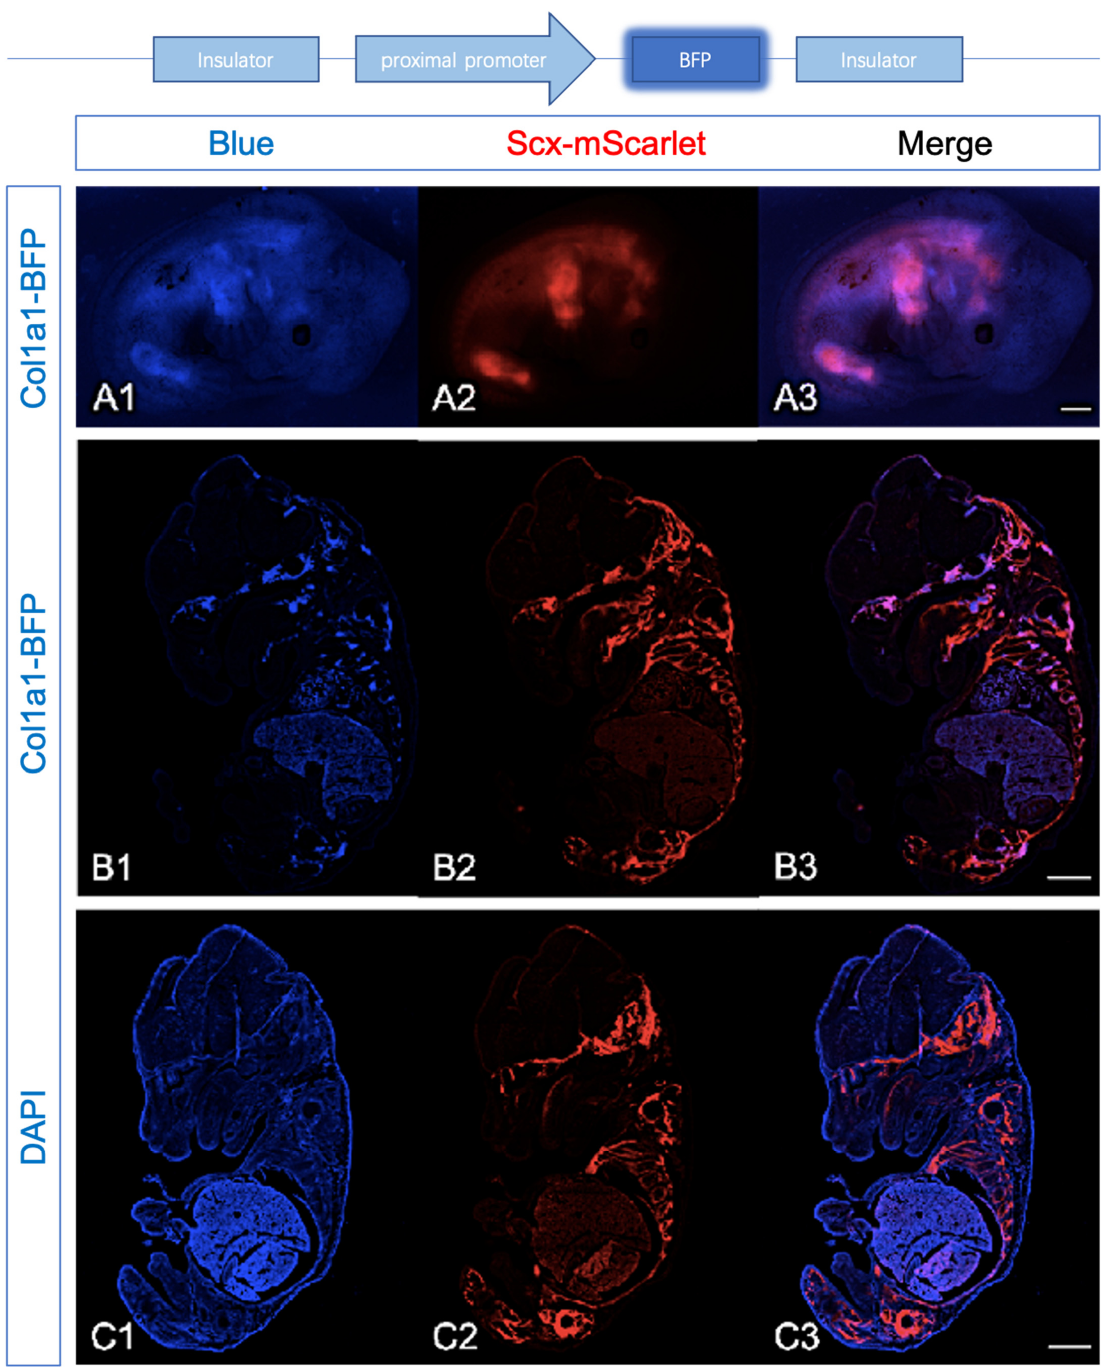
Figure 3. Areas of Col1a1 -BFP expression coincided with Scx -mScarlet. To characterize transgenic mice, we detect the reporter signals of the whole-mount embryos using the binocular fluorescence microscope. Then, we also performed the